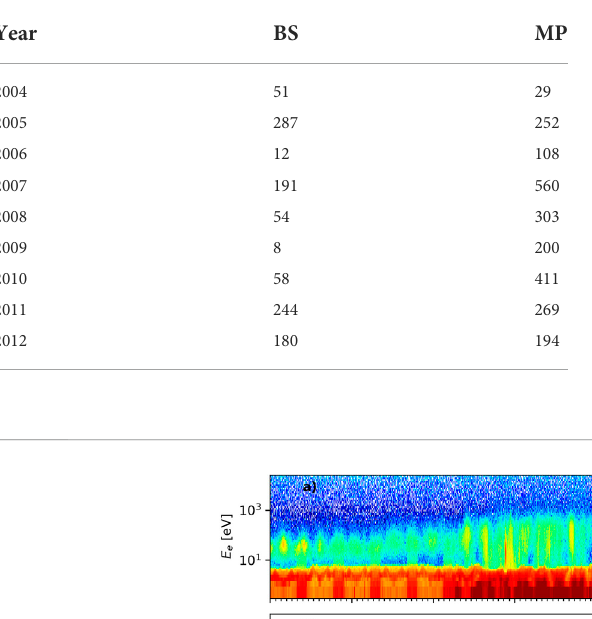
TABLE 3 Breakdown of the number of bow shock (BS) and magnetopause (MP) crossings in the new list of boundary crossings between years 2004 – 2012.